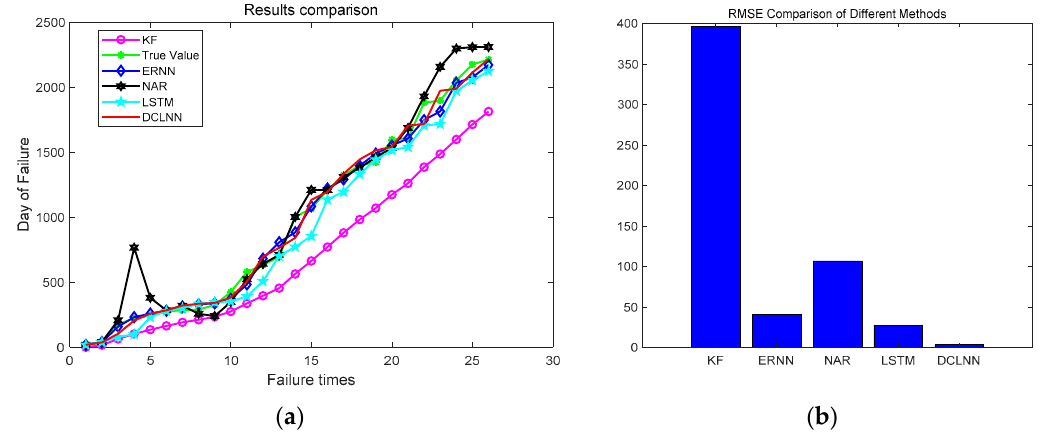
Figure 17. Result comparison. ( a ) Comparison of different methods. ( b ) Comparison of RMSE with different methods.